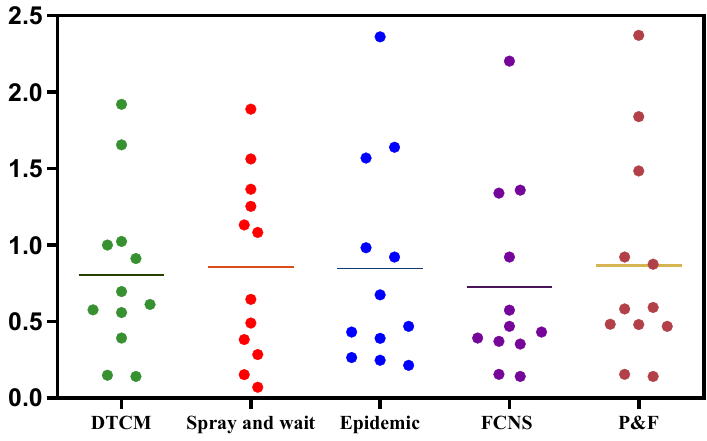
Figure 9. Distribution of standard deviation from the experiments on delay comparison.